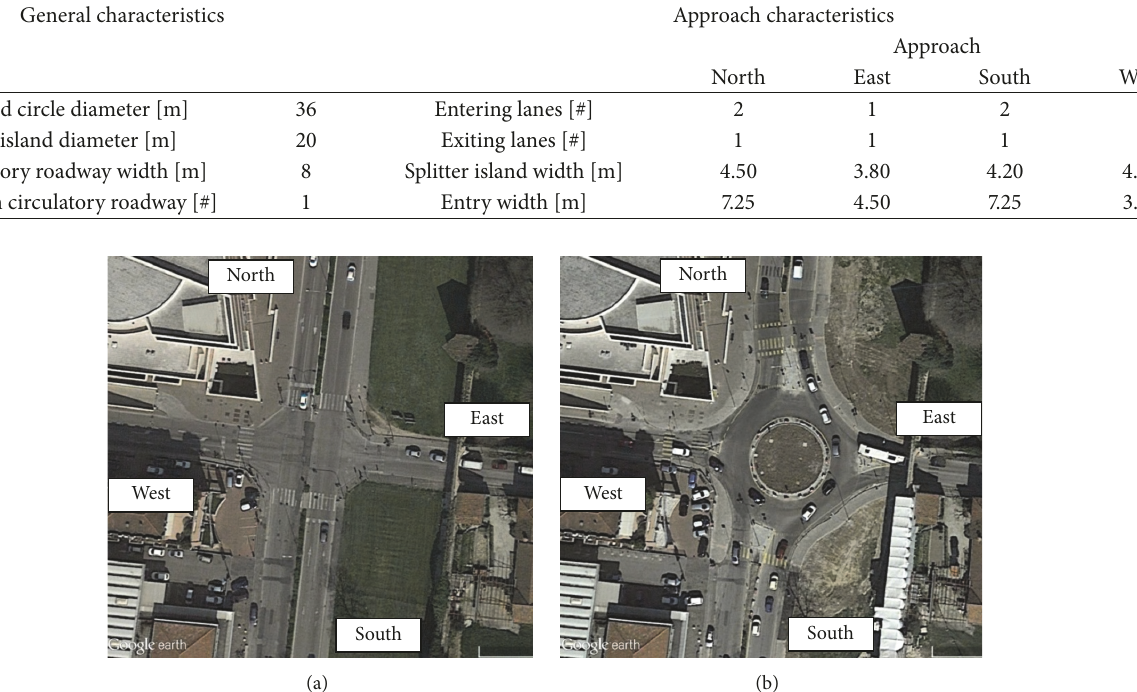
Figure 1: Aerial photograph of the study site: (a) signal-controlled intersection; (b) roundabout